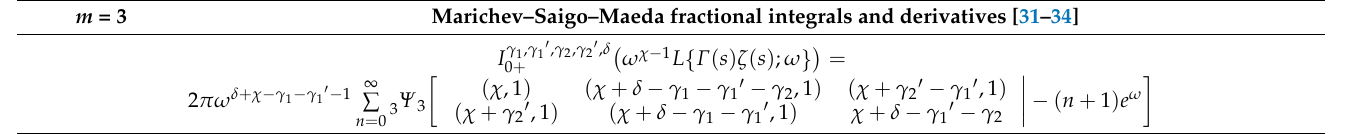
Table 1. Fractional integrals and derivatives formulae involving Riemann zeta-function. m =